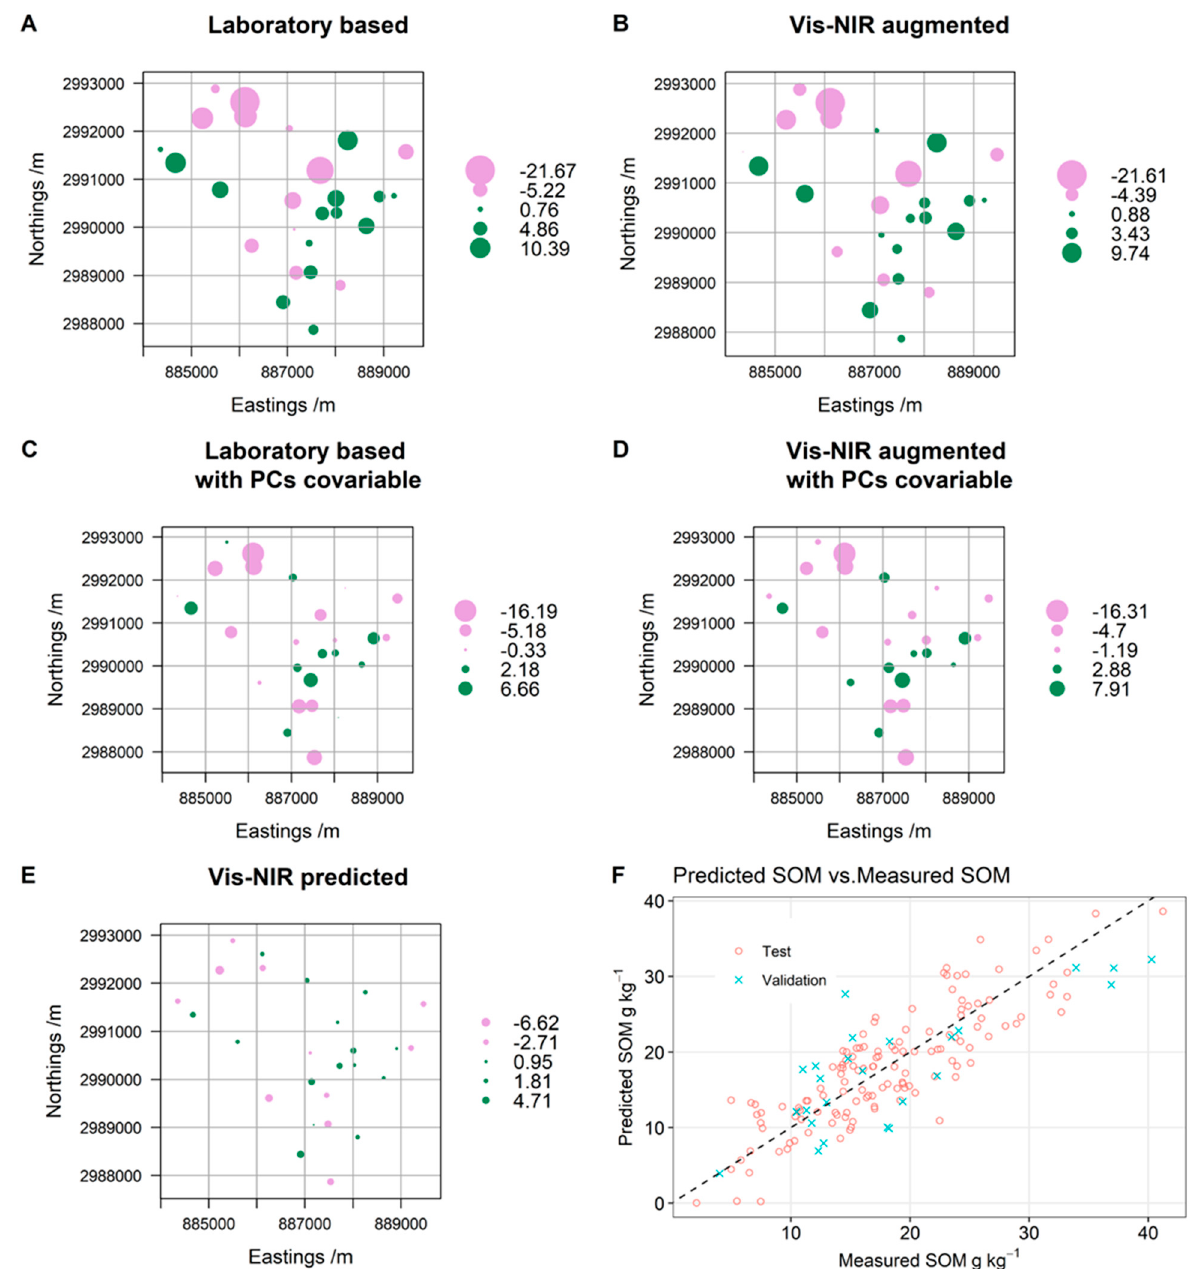
Figure 9. The location of the difference value of predicted and measured SOM from Lb ( A ), Au.p ( B ), Ld.co ( C ), and Au.p.co ( D ), and from the vis ‐ NIR Model ( E ) of the validation dataset, the SOM content from the predicted and measured dataset from the test and validation dataset, and the plot of measured SOM and predicted SOM ( F ). The data showed in ( A )–( E ) was the difference of the measured SOM minus the predicted SOM.